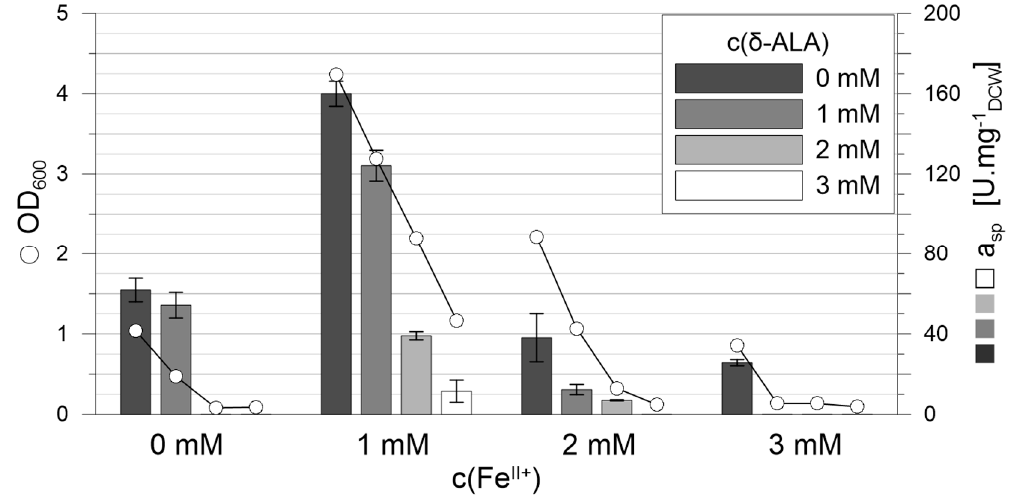
Figure 4. Final OD 600 and specific activity of E. coli JM109(DE3) expressing HPL.